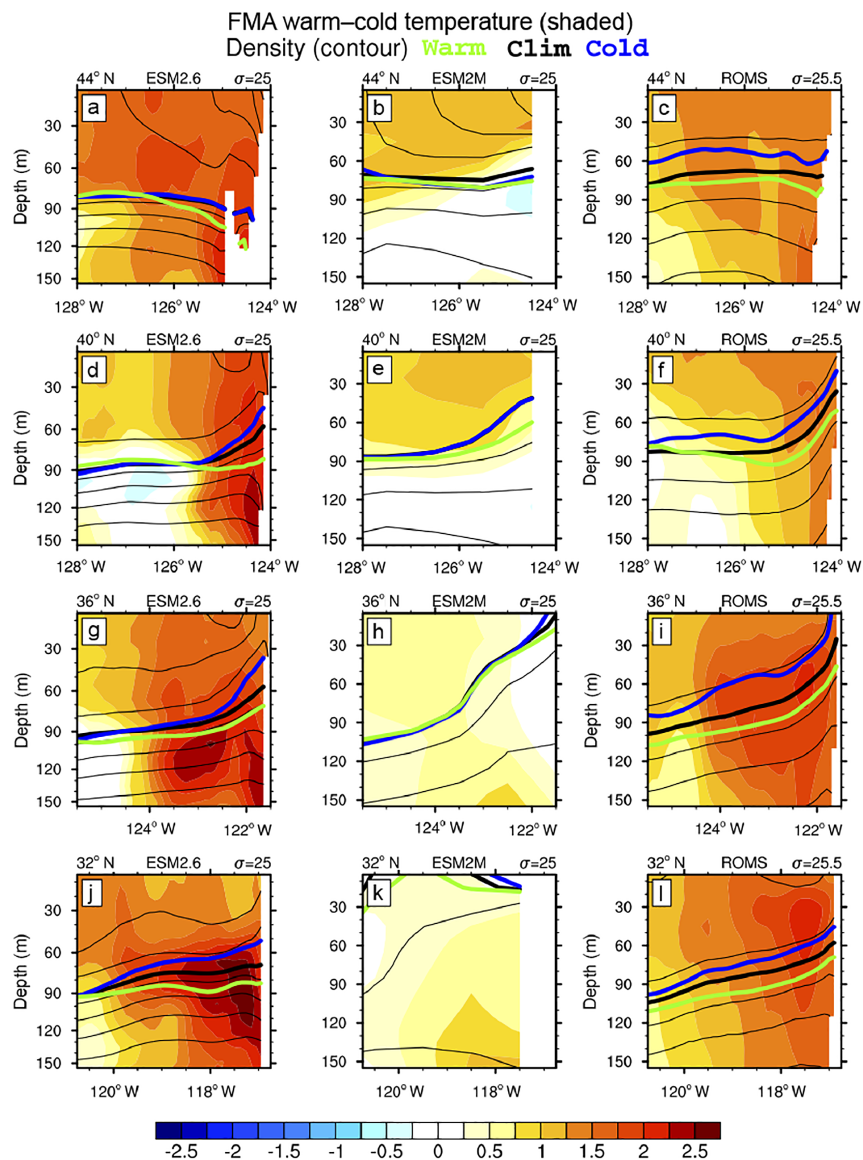
Figure 2. ESM2.6 depth–longitude cross sections of FMA warm–cold high-pass-filtered standardized anomalies of temperature (unitless) for (first column) ESM2.6, (second column) ESM2M, and (third column) ROMS. The contours show the mean climatological density lines (first row) 44 ◦ N, (second row) 40 ◦ N, (third row) 36 ◦ N, and (fourth row) 32 ◦ N for the 222km nearest the US west coast. The bold lines show the positions for the σ = 25 level (ESM2.6 and ESM2M) and the σ = 25 . 5 level (ROMS) for the climatology (black), El Niño conditions (green), and La Niña conditions (blue), and the thin lines indicate density increments of